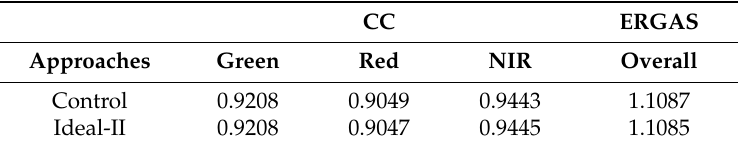
Table 6. CC and ERGAS of the fusion results applied to the Panyu images for both control and Ideal-II